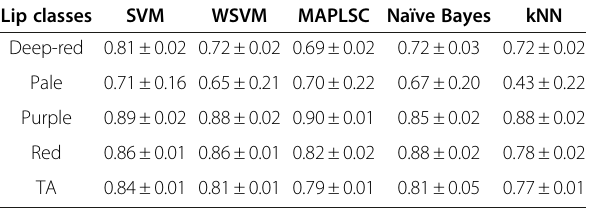
Table 2 Accuracy of lip image classification using SVM, WSVM, kNN,MAPLSC and Naive Bayes on the features selected by SVM-RFE (mean± variance) Lip classes SVM WSVM MAPLSC Naïve Bayes